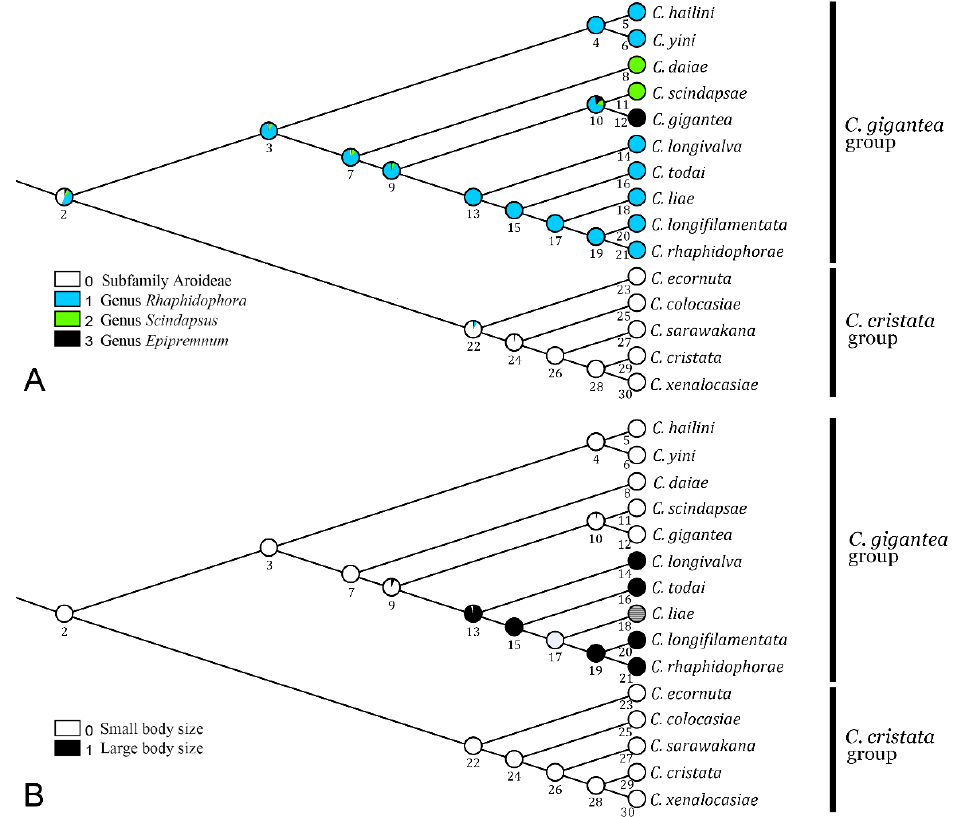
Figure 4. Evolutionary scenarios in ( A ) host plant use and ( B ) body size in the C. gigantea and C. cristata species groups. See Table A2 for data on body size.